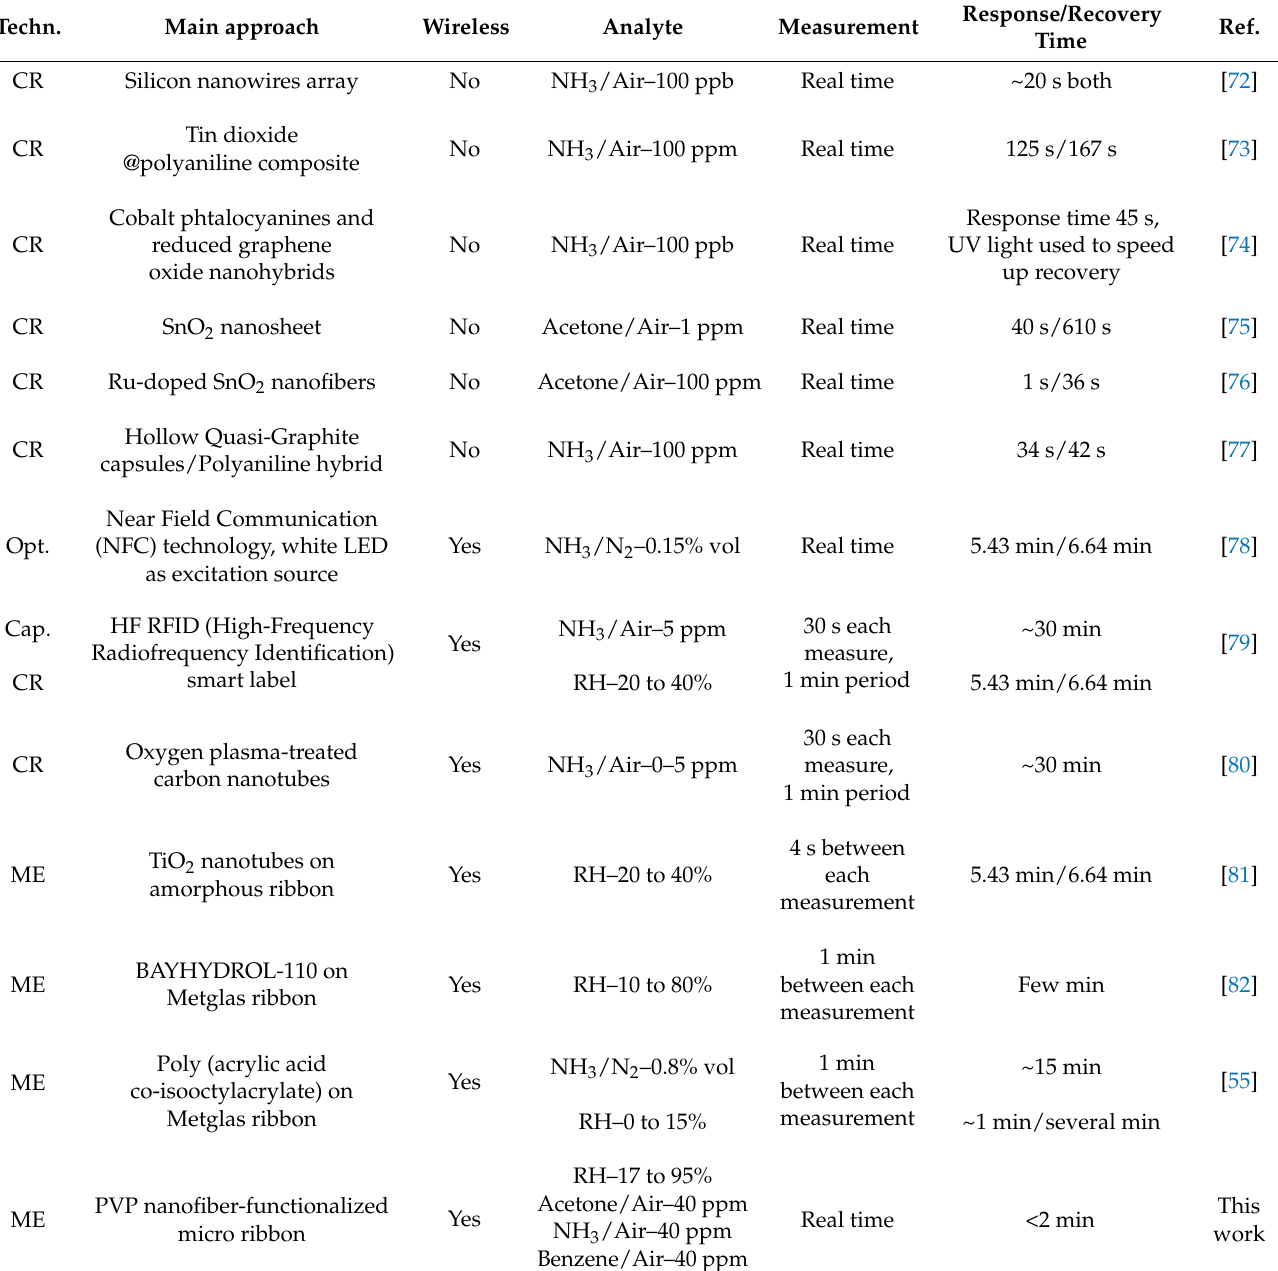
Table 1. Comparison table for different sensor technologies